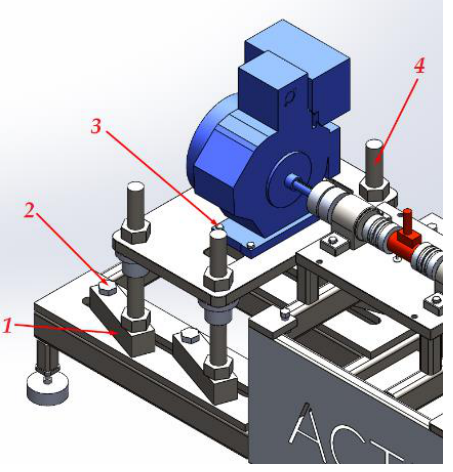
Fig. 2. Parts enabling positioning of the engine